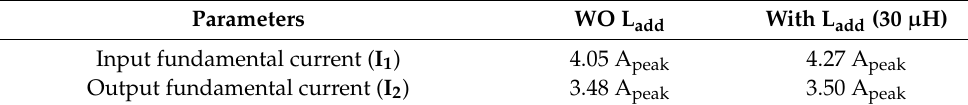
Table 13. Experimental results of a 30 W class WPT system according to the presence of L add (30 μH ).